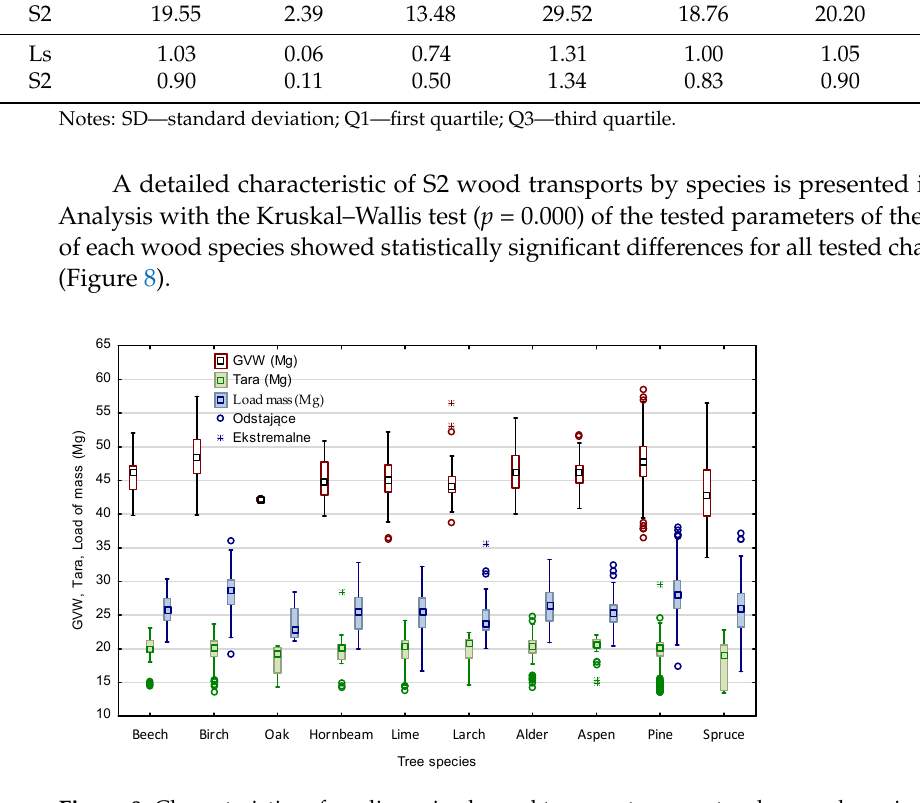
Figure 8. Characteristics of medium-sized wood transport parameters by wood species. 3.4. Comparison of Real GVW with Calculated Values for Medium-Sized (S2) Wood Transports The real total gross vehicle weight of the transport sets (GVW actual ) with S2 wood loads is significantly higher than the legislated weight (GVW law ) and is different for broadleaf and coniferous wood (Figure 9). The average GVW actual for broadleaf wood deliveries is 46.27 Mg (median 46.21) and coniferous is 46.52 Mg (median 46.50). The mean and median values of the calculated GVW (law, IFOVEA and Timberet) are similar, as confirmed by Dunn’s multi-sample rank mean comparison test ( p = 0.451 and p = 0.112), which can be interpreted as no effect of the measurement method (iFOVEA, Timberet) on GVW law (Figure 9a). The measurement error of the coniferous wood piles with the iFOVEA application ( − 12.82%) significantly underestimates the obtained GVW law values (Figure 9b), and the results obtained are statistically significantly different (Kruskal–Wallis test p = 0.000).